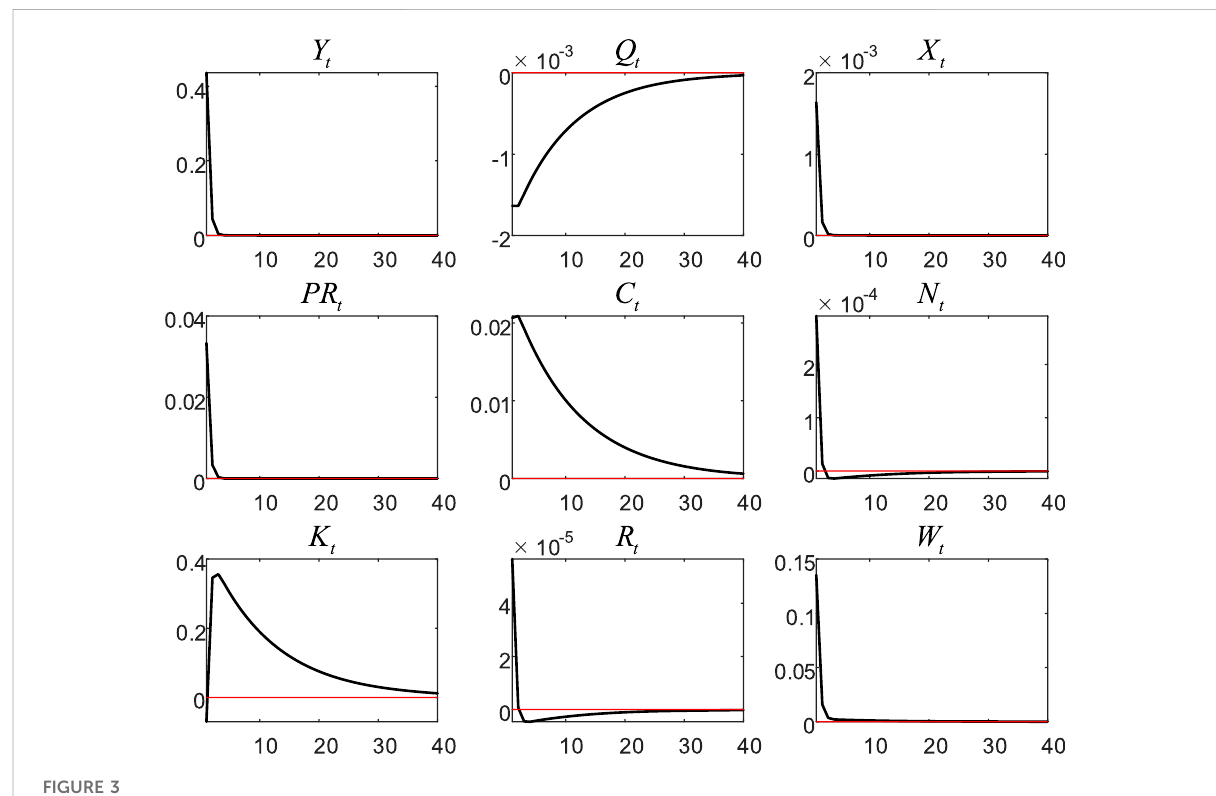
FIGURE 3 The impulse response of intensity of standardized